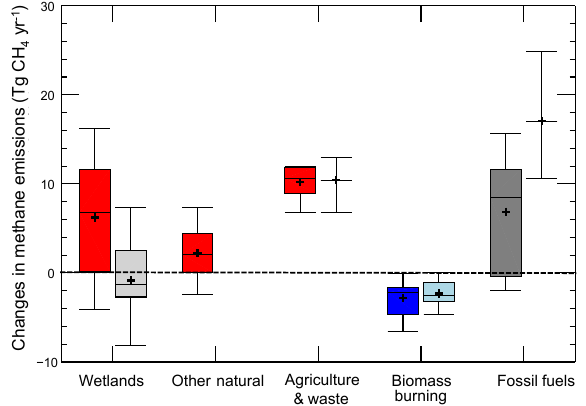
Figure 5. Changes in methane emissions between 2002–2006 and 2008–2012 inTg CH 4 yr − 1 for the five source types. Red box plots indicate a significant positive contribution to emission changes (first and third quartiles above zero), blue box plots indicate a significant negative contribution to emission changes (first and third quartiles below zero), and grey box plots indicate non-significant emission changes. Dark (light) coloured boxes are for top-down (bottom-up) approaches (see text for details). The median is indicated inside each box plot (see Methods, Sect. 2). Mean values, reported in the text, are represented with “ + ”